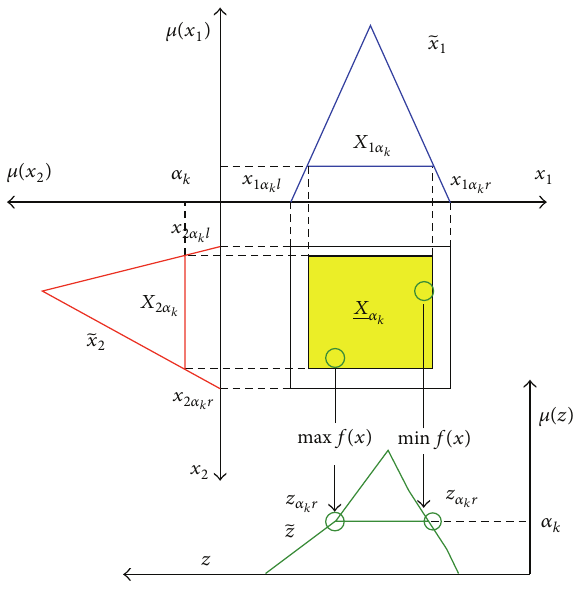
Figure 1: The 𝛼 -level